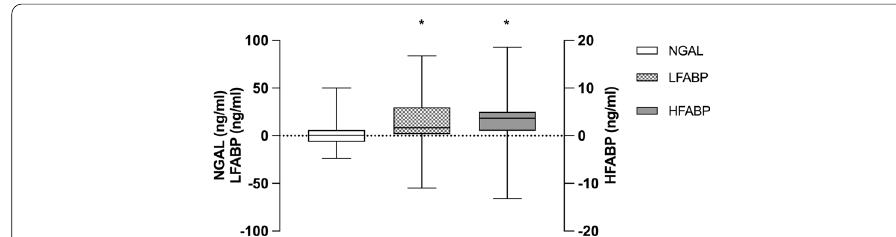
Fig. 2 Trans-renal gradients of NGAL, LFABP and HFABP. NGAL neutrophil gelatinase-associated lipocalin, LFABP liver-type fatty-acid binding protein, HFABP heart-type fatty-acid binding protein. * p < 0.01 for renal venous blood vs. renal arterial blood. Trans-renal gradients were calculated as the concentration in arterial blood subtracted from the concentration in renal venous blood. The boxes represent median and